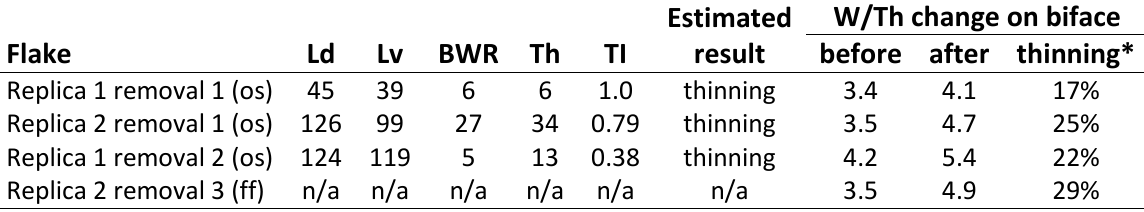
Table 3. Estimated thinning result based on flake measurements (Bradley et al. 2010:75) compared to measured thinning. Abbreviations: os - overshot; ff - full face; Ld - dorsal length; Lv - ventral length; BWR - biface width reduction; Th - thickness; TI - thinning index; *calculated by dividing “before W/Th” by “after W/Th” and subtracting from 100%; n/a - not available. (See also Tables 1 and